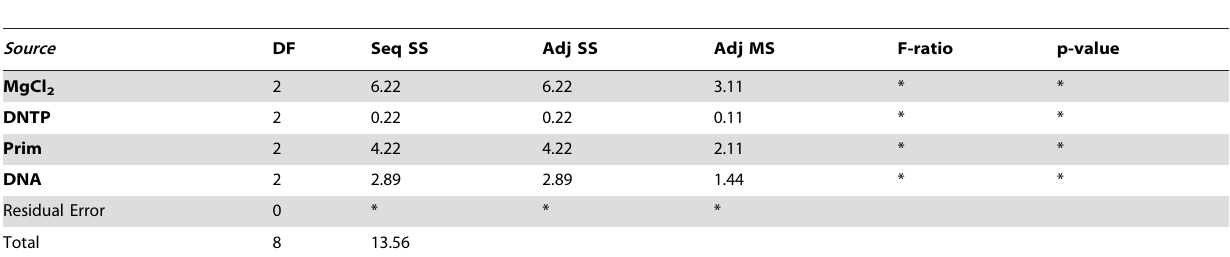
Table 4. ANOVA results for the PCR data of epidemiological typing of Pseudomonas aeruginosa above (MINITAB 16.2).